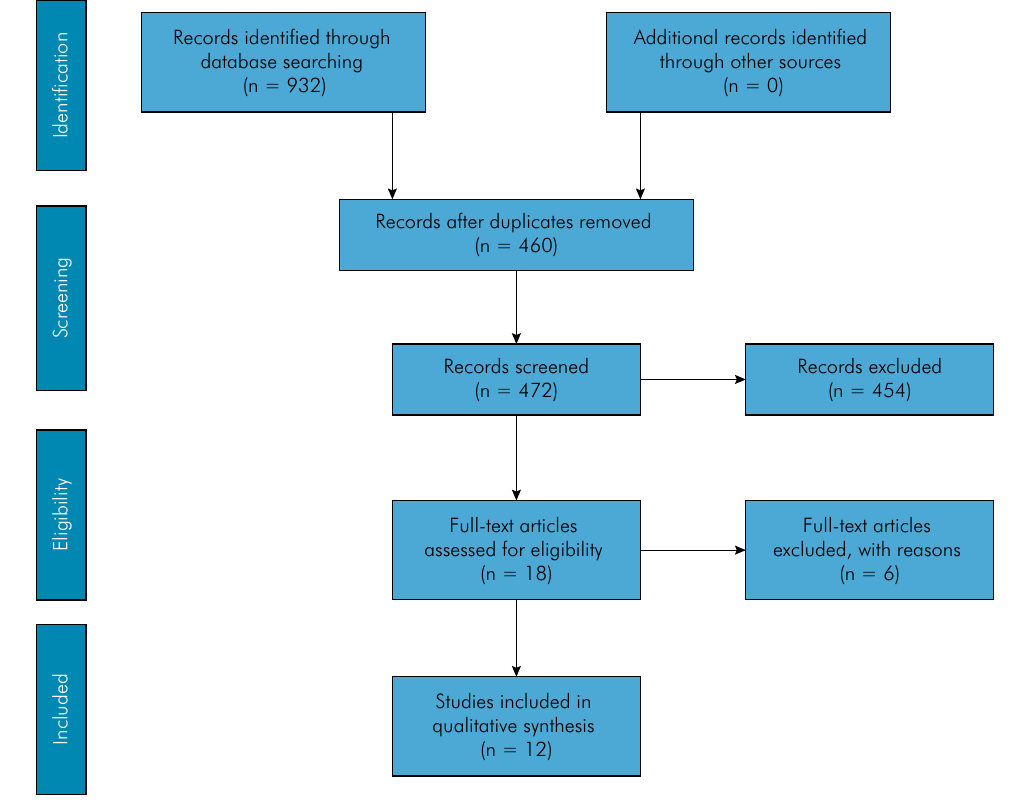
Figure. Flowchart of the selection of the